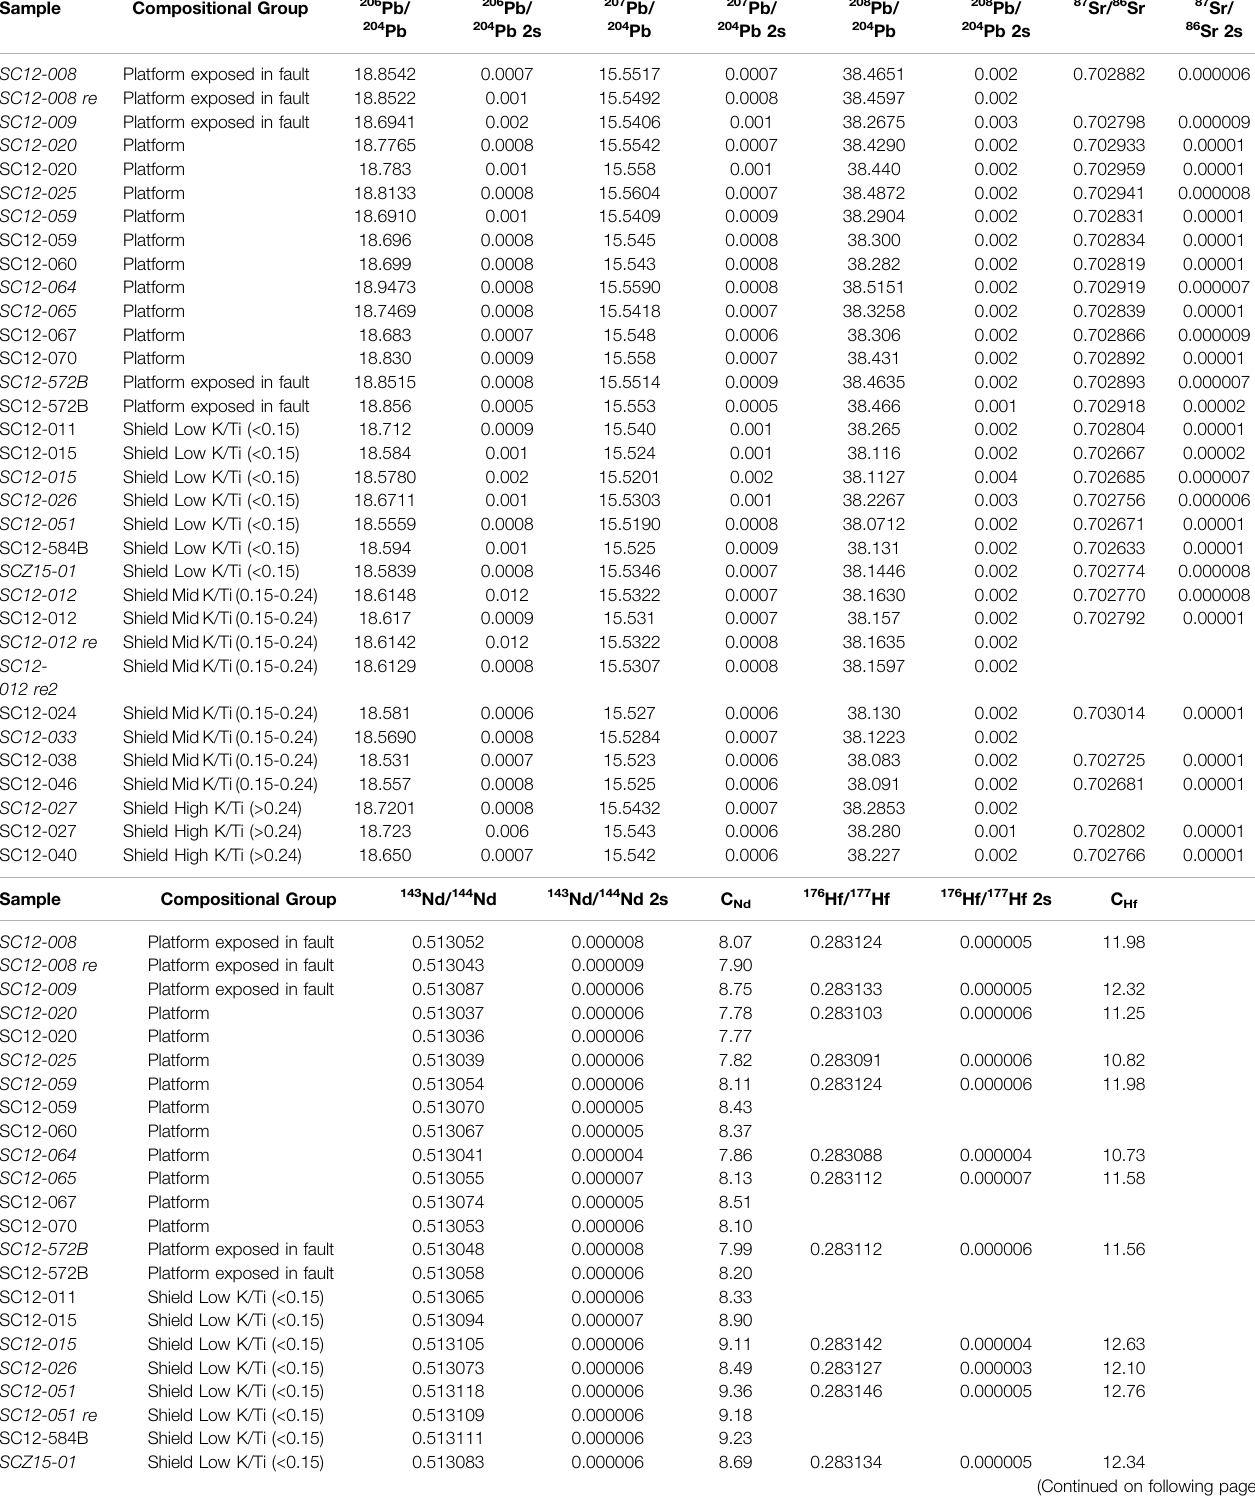
TABLE 3 | Radiogenic isotope ratios for Santa Cruz